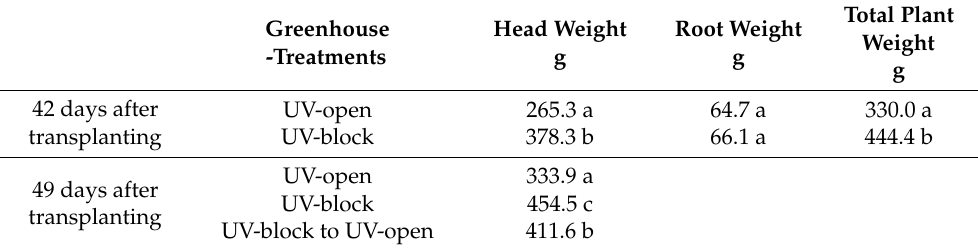
Table 2. Effects of greenhouse cover transparency in UV-A radiation on growth parameters of red lettuce (Redino Lollo rosso) 42 and 49 days after